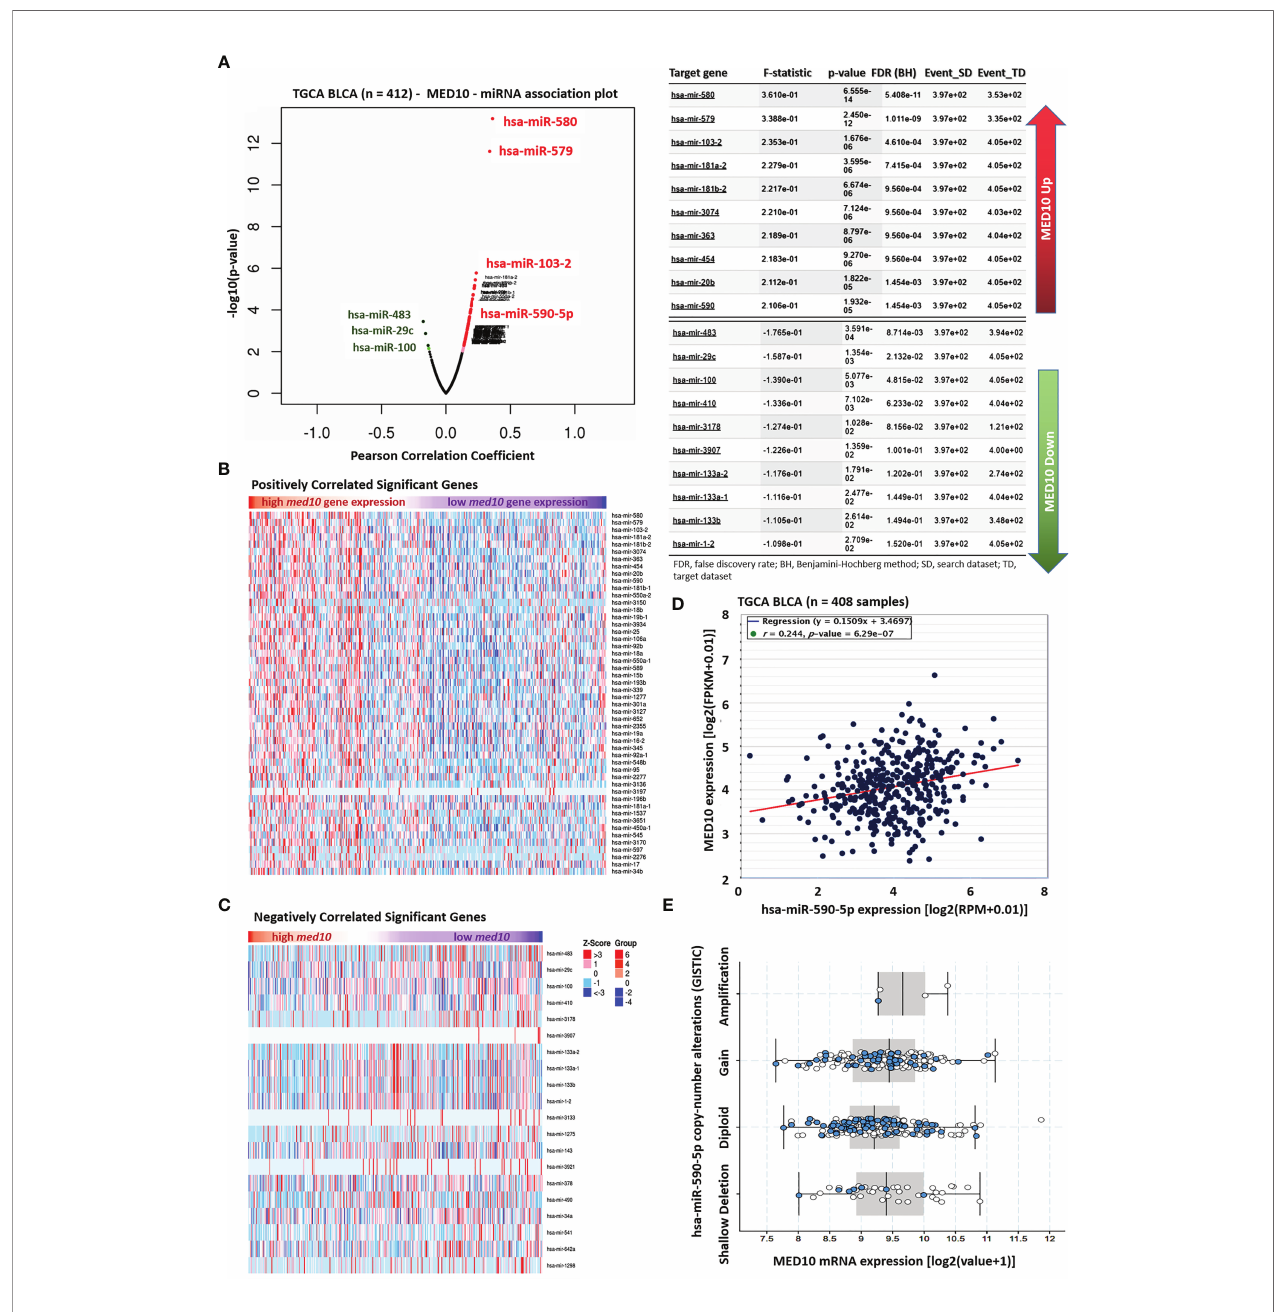
FIGURE 3 | MED10 is functionally co-expressed with hsa-miR-590 but is inversely associated with tumor-suppressor microRNAs. (A) Association plot of the relationship between the expression of MED10 and miRs in the TCGA BLCA cohort (left) . Chart showing the 10 topmost miRs associated with upregulated or downregulated MED10 expression (right) . Heatmaps showing (B) positively and (C) negatively correlated signi fi cant miRs in the TCGA BLCA cohort. (D) Line and dot plots showing the correlation between MED10 and hsa-miR-590-5p expression levels in the TCGA BLCA cohort. FPKM, fragmented per kilobase of transcript per million; RPM, reads per million total/ mapped reads. (E) Box and whiskers plot showing the association between MED10 mRNA expression and hsa-miR-590-5p copy number